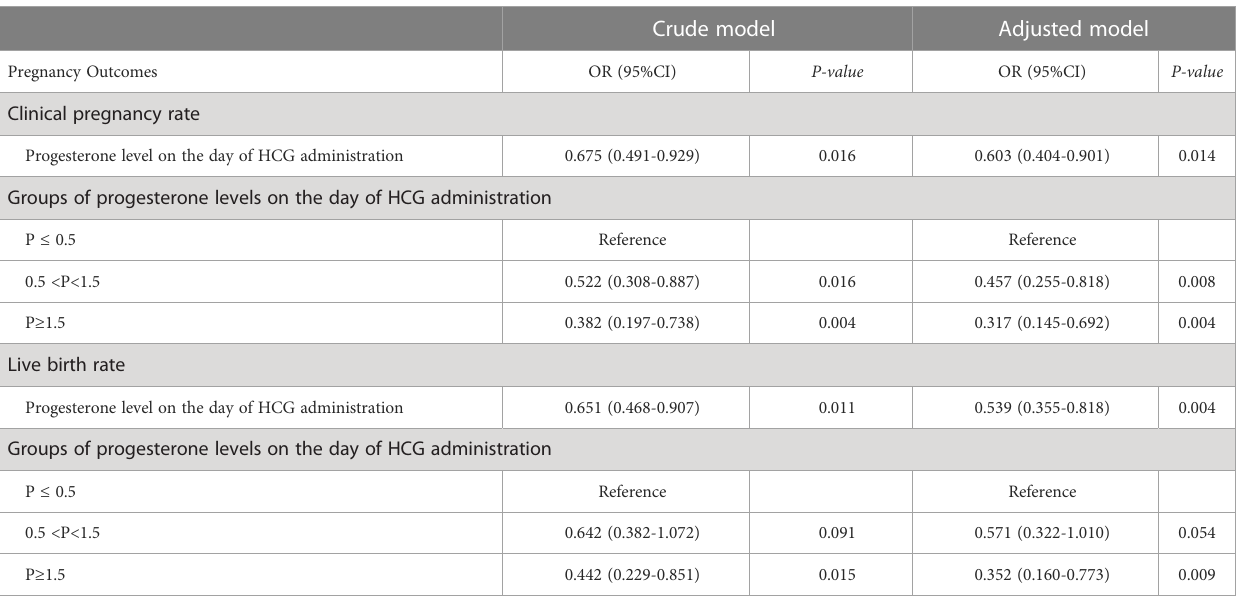
TABLE 4 Multivariate logistic regression models regarding the pregnancy